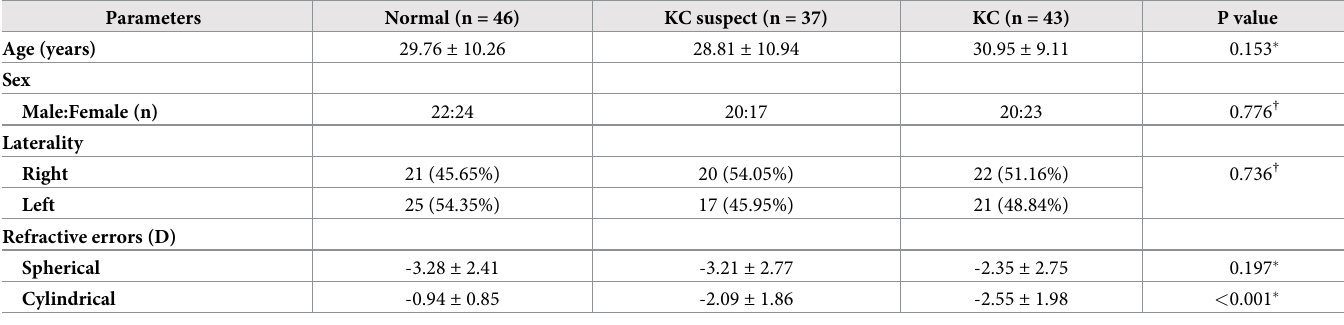
Table 1. Patient demographics of three